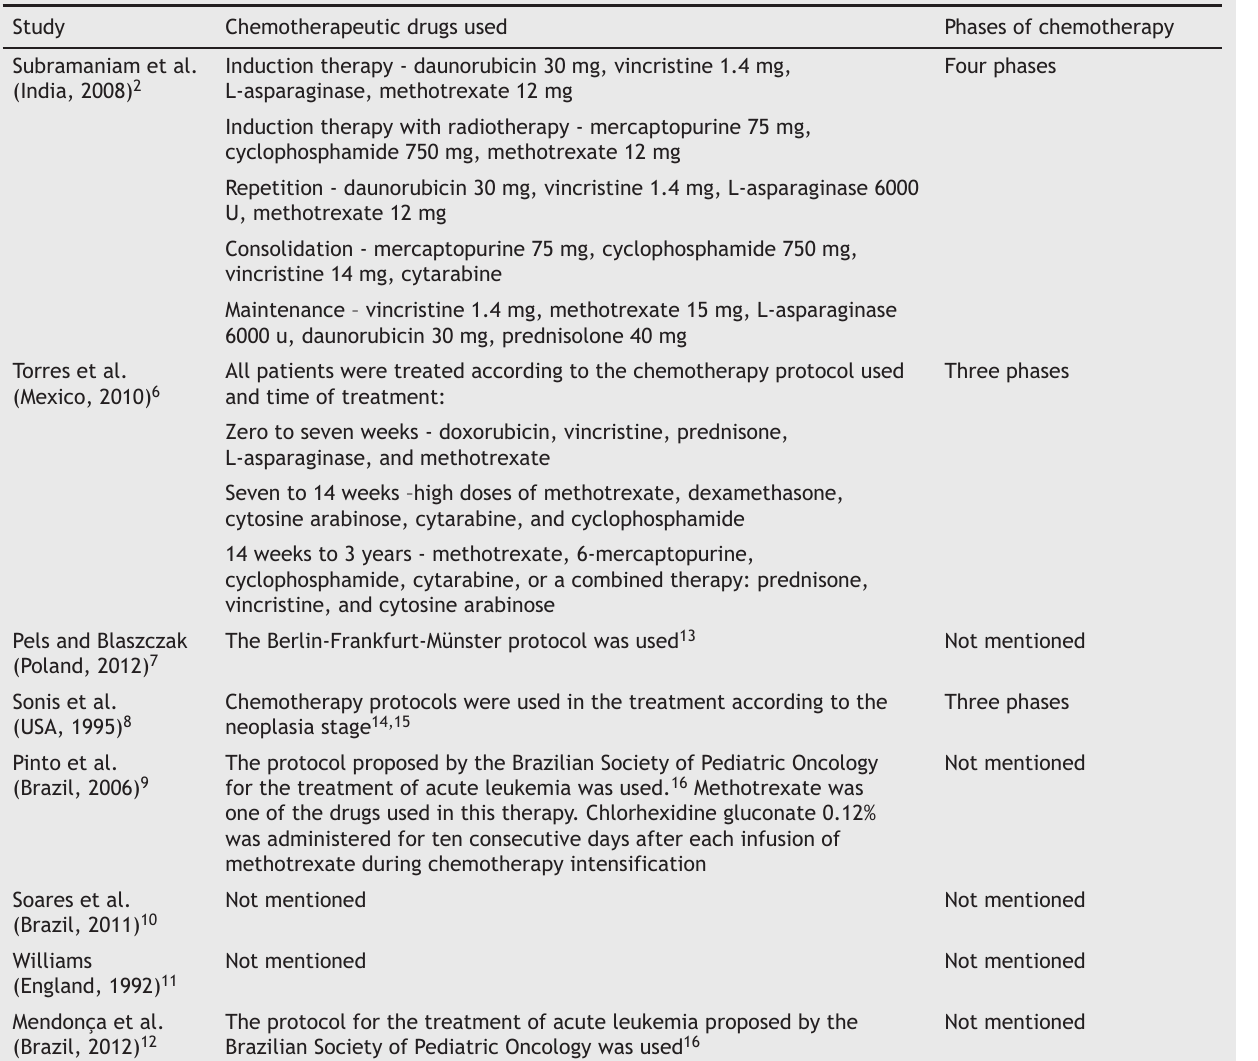
Table 4 Chemotherapeutic drugs used and phases of